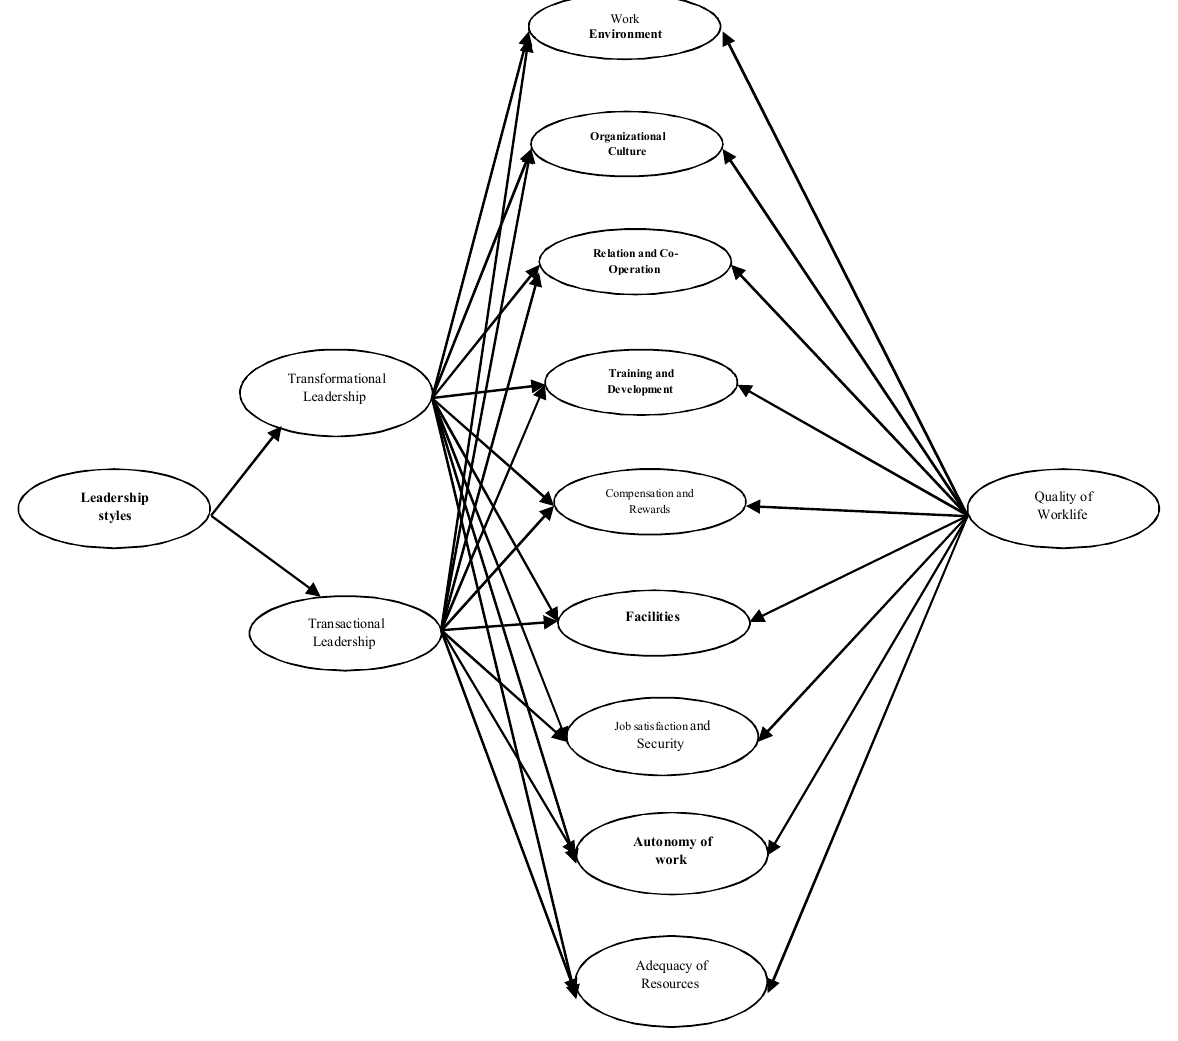
Fig. 2. Conceptual